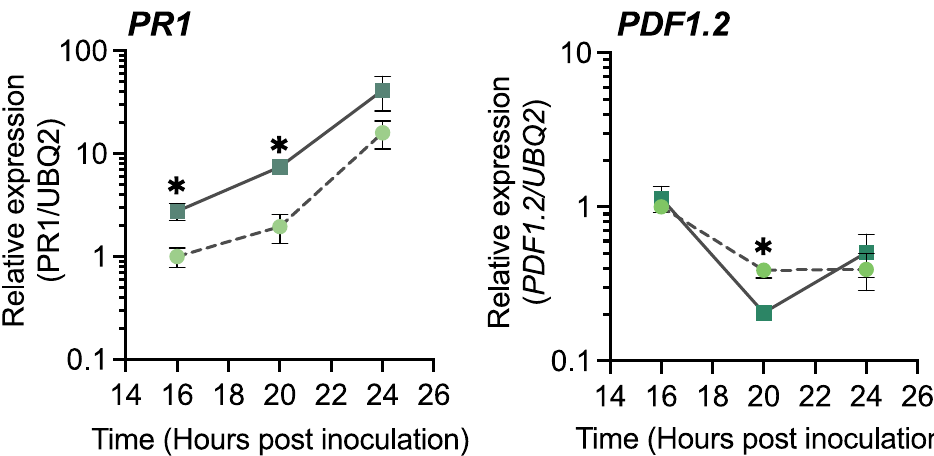
Figure 6. Expression of PR1 and PDF1.2 after pathogen infection in GR24-treated plants. Three-week-old plants were treated with 0.02% acetone (control) or 10 µ M GR24 by drenching the soil 3 d before inoculation with Pst (2 × 10 7 CFU/mL). Leaves were collected 16, 20, and 24 h after Pst inoculation. Closed circle, water-treated control plants; closed square, GR24-treated plants. Significant differences between control and GR24 treatments are indicated by * (unpaired t -test, p < 0.05).